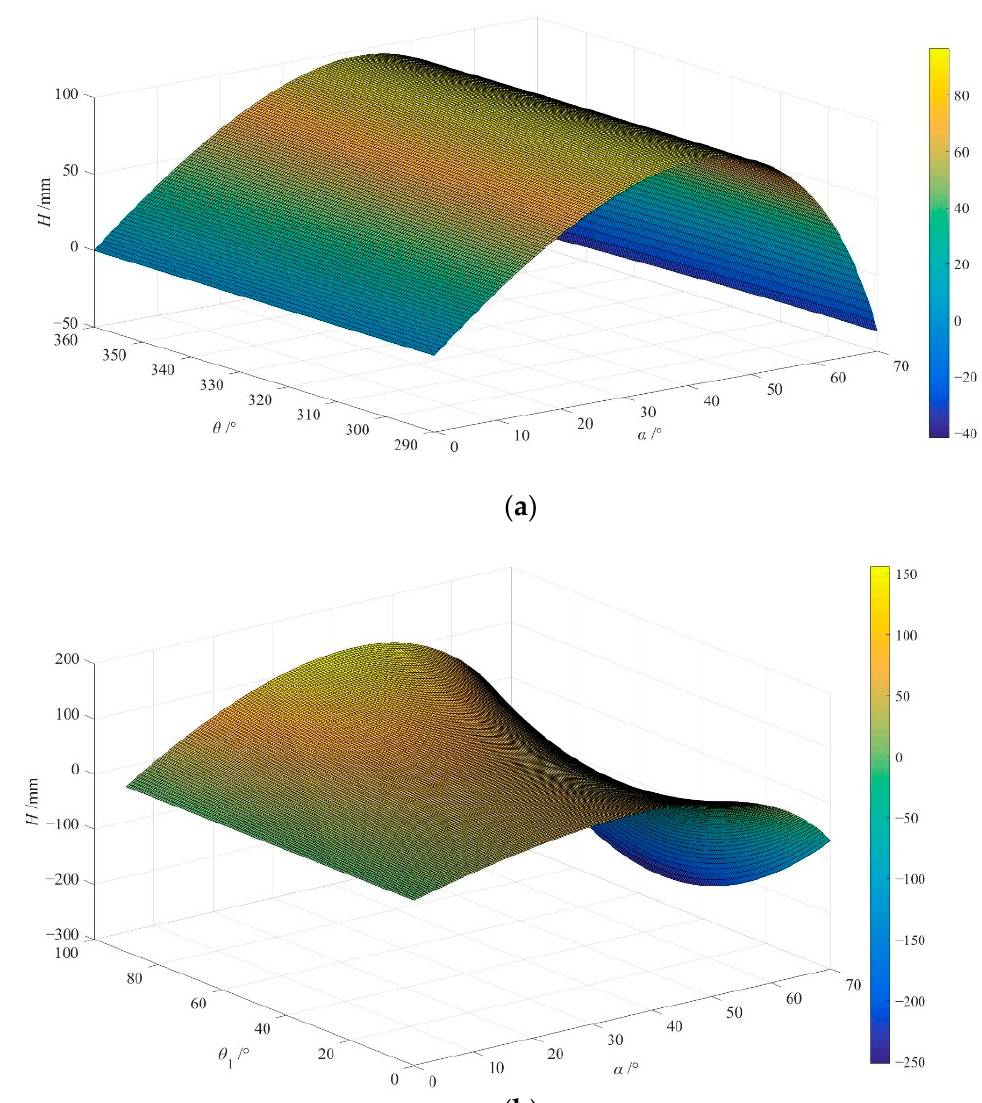
Figure 10. Simulation analysis: ( a ) with a positive obstacle height H , body elevation angle α and radial angle θ of the 3D curved surface; ( b ) reverse with the obstacle height H , body elevation angle α and rocker arm and body angle θ 1 of the 3D surface.